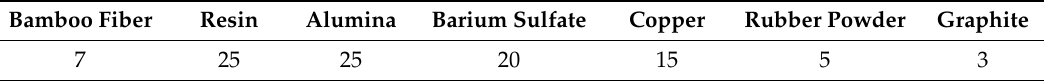
Table 3. Formulation of composites (mass fraction, %).